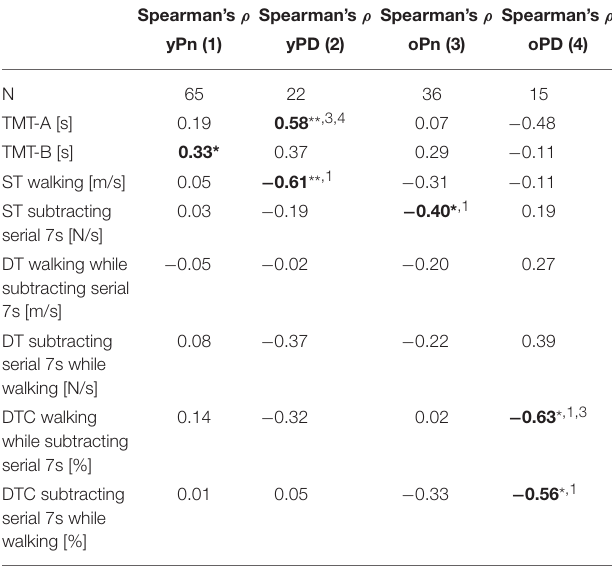
TABLE 2 | Correlation coefficients between white matter changes, and gait and executive function parameters, sorted by